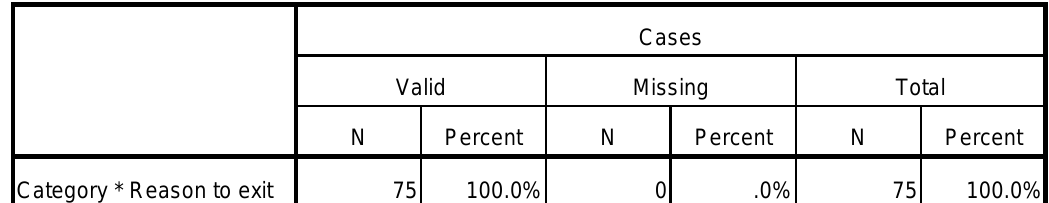
Table 1: Case Processing